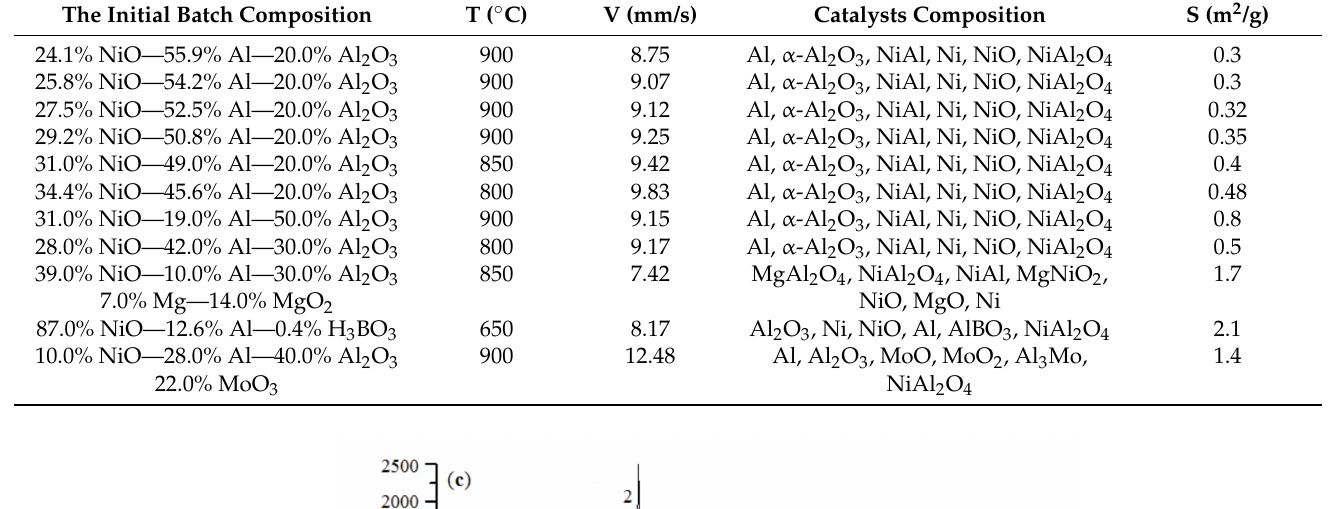
Table 1. The initial batch and catalysts’ composition, preheating temperature, combustion rate (V), and surface area (S).